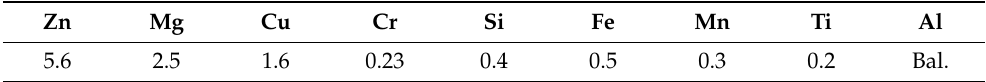
Table 1. Chemical compositions of the experimental 7075 aluminium alloy obtained by OES (wt.%). Zn Mg